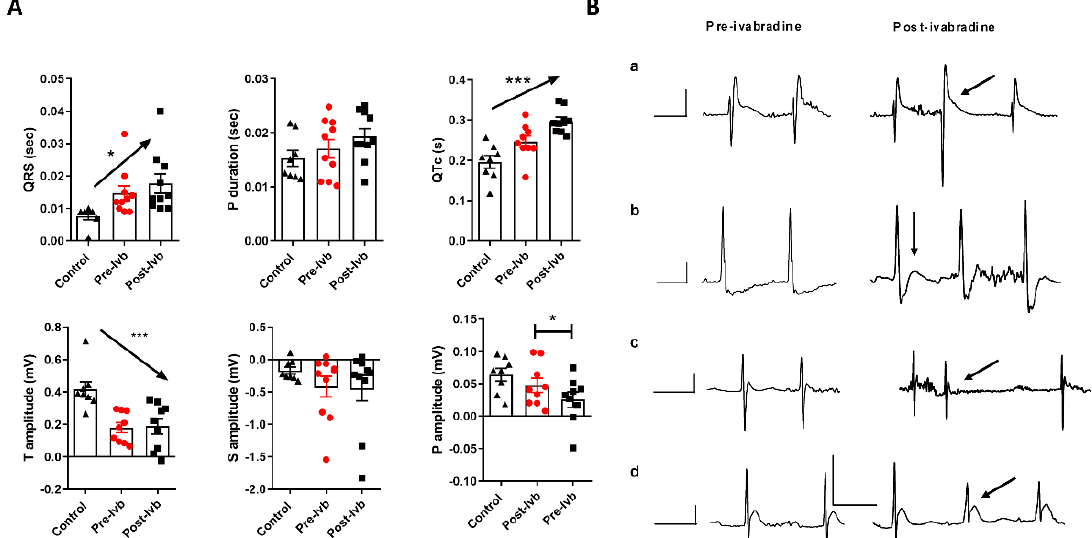
Figure 2. Quantitative/qualitative analysis of ECG parameters after a single-dose treatment with ivabradine (Ivb) in mice at the EA phase of infection. ( A ). ECG intervals (QRS, P duration, and QTc) and amplitudes (T, S, and P) were determined for control and infected mice before (Pre-Ivb) and after (Post-Ivb) treatment with ivabradine. An unpaired Student’s t -test was performed for statistical comparison (* p < 0.05), and a one-way ANOVA post-test for trends indicated in arrows (* p ≤ 0.05 and *** p ≤ 0.001). ( B ) Representative ECG recordings pre- and post-Ivb treatment. Registers a–d were taken from different infected mice, where a indicates a junctional ectopic beat (arrow), b the QRS enlargement with S blockage, and c–d illustrate atrial ectopic beats.